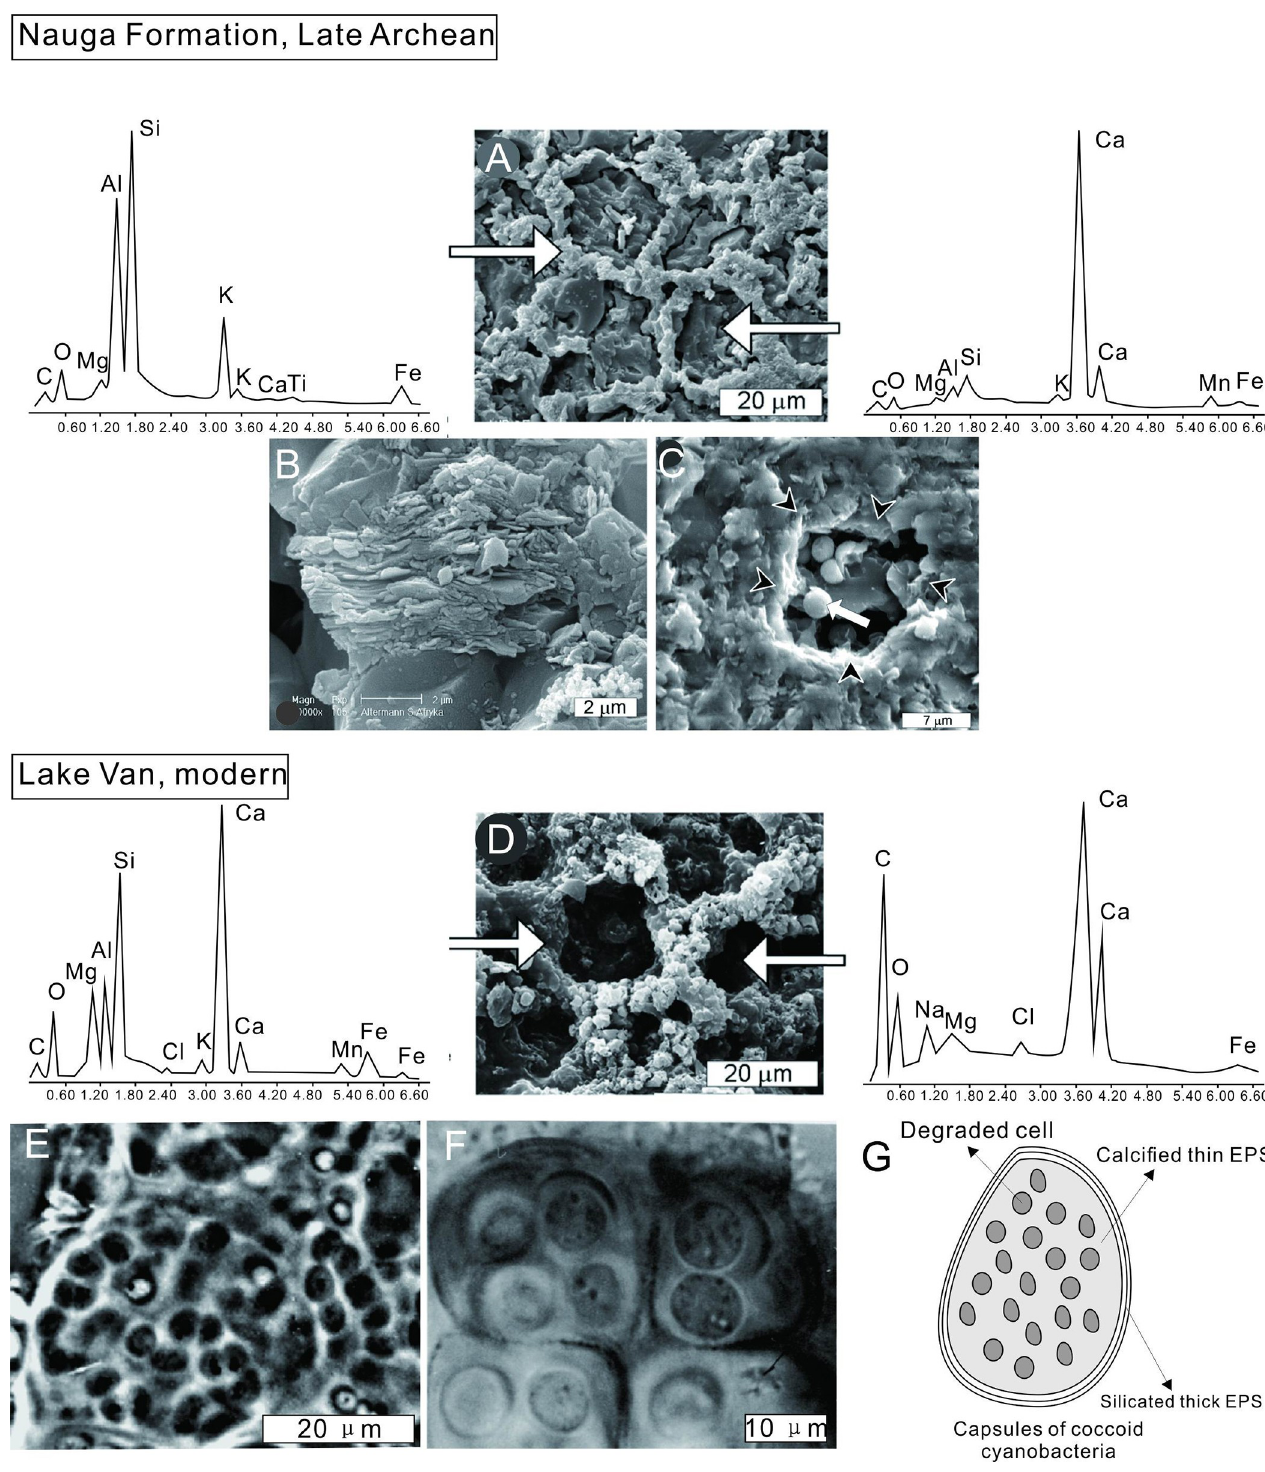
Fig 7. Archean and modern analogues of Epiphyton . (A–C) Archean calcified coccoid cyanobacteria (modified after Kazmierczak et al . [26]) showing honeycomb patterns, layered envelopes, pits with silicified cocci and identical elements. (D) A modern coccoid cyanobacterial mat from Lake Van (Turkey) (modified after Kazmierczak et al . [26]) showing honeycomb structure and similar elements. (E) Examples of degradation cocci and remaining pits from Lake Van [26]. (F) Colonies with a number of cells contained within an outer membrane, which represent a prototype of mineralized capsules [39]. (G) Model to show the correspondence between cocci colonies in vivo and the mineralized